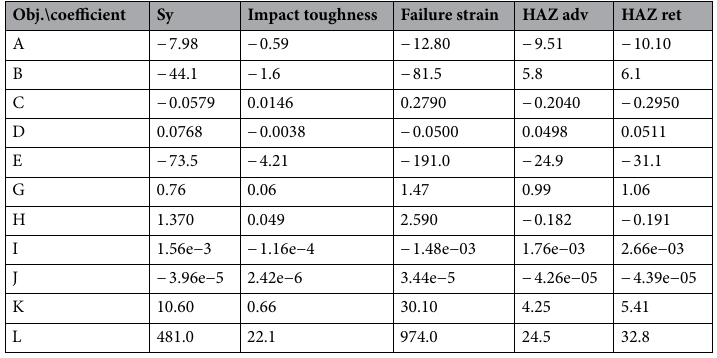
Table 5. The quadratic coefficients of response surface for the objective functions of conical pin.